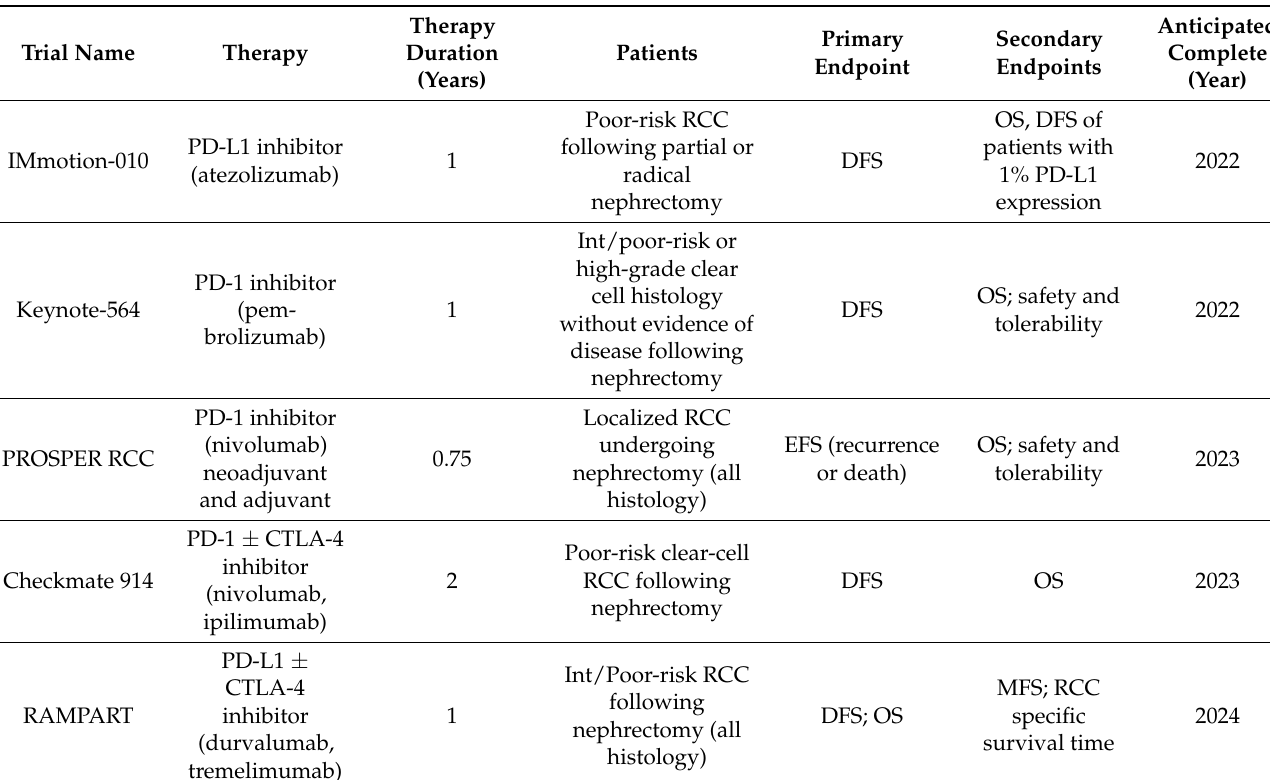
Table 4. Ongoing randomized clinical trials for checkpoint inhibitors as adjuvant therapy for localized renal cell